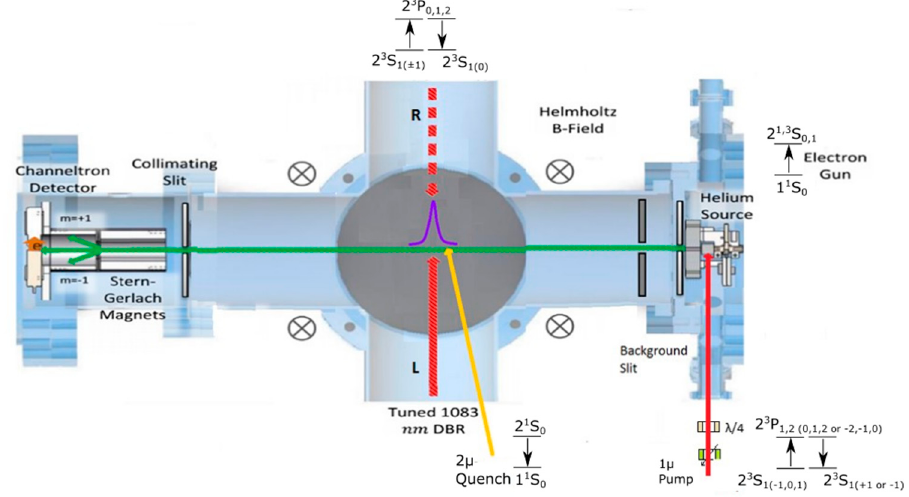
Figure 1. Atomic beam apparatus: Helium Source is the area of interest.